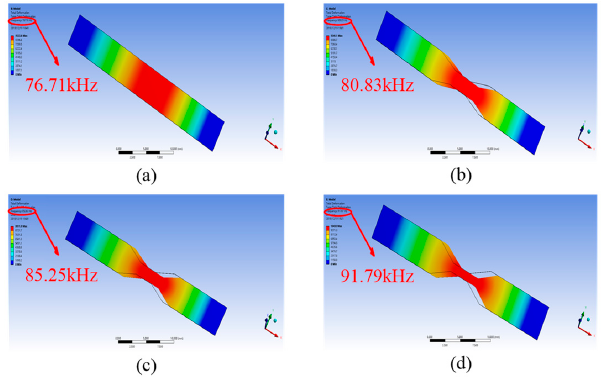
Figure 8. FEM analysis results of resonant frequency under different d 1 / d 2 . ( a ) d 1 / d 2 = 1, ( b ) d 1 / d 2 = 2, ( c ) d 1 / d 2 = 3, and ( d ) d 1 / d 2 = 4.